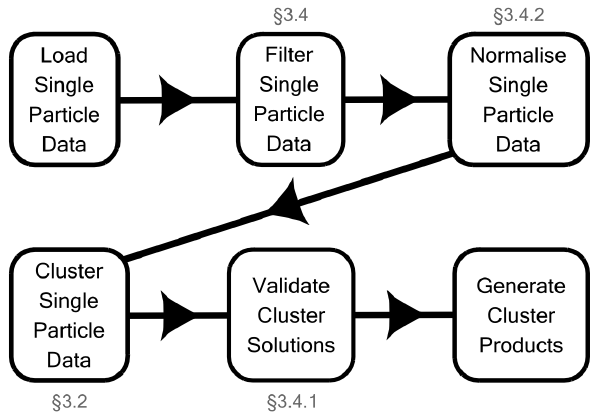
Figure 1. Schematic of procedure followed to generate cluster prod- ucts from raw data. Relevant sections for each sub-procedure are labelled where